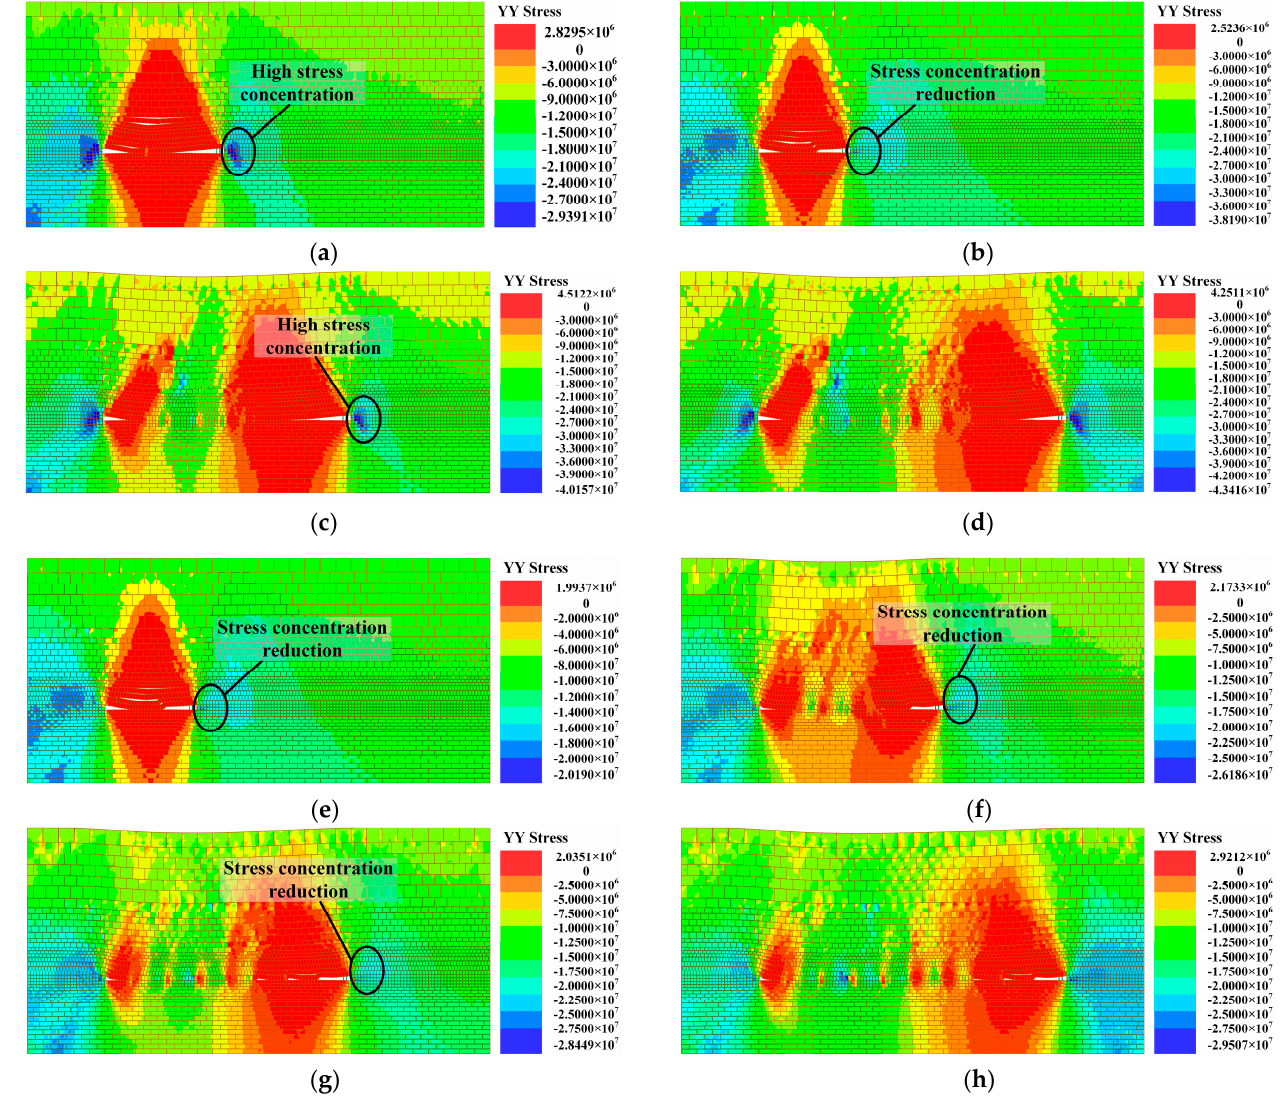
Figure 12. Variations in the stress cloud diagram: ( a ) is the stress state when the working face is first broken when the roof is not cut; ( b ) is the stress state when the working face is excavated for 100 m when the roof is not cut; ( c ) is the stress state when the working face is excavated for 160 m when the roof is not cut; ( d ) is the stress state when the working face is excavated for 200 m when the roof is not cut; ( e ) is the stress state when the working face is excavated for 60 m after cutting the roof; ( f ) is the stress state when the working face is broken for the first time after cutting the roof; ( g ) is the stress state when the working face is excavated for 60 m after cutting the roof; and ( h ) is the stress state when the working face is excavated for 200 m after cutting the roof.